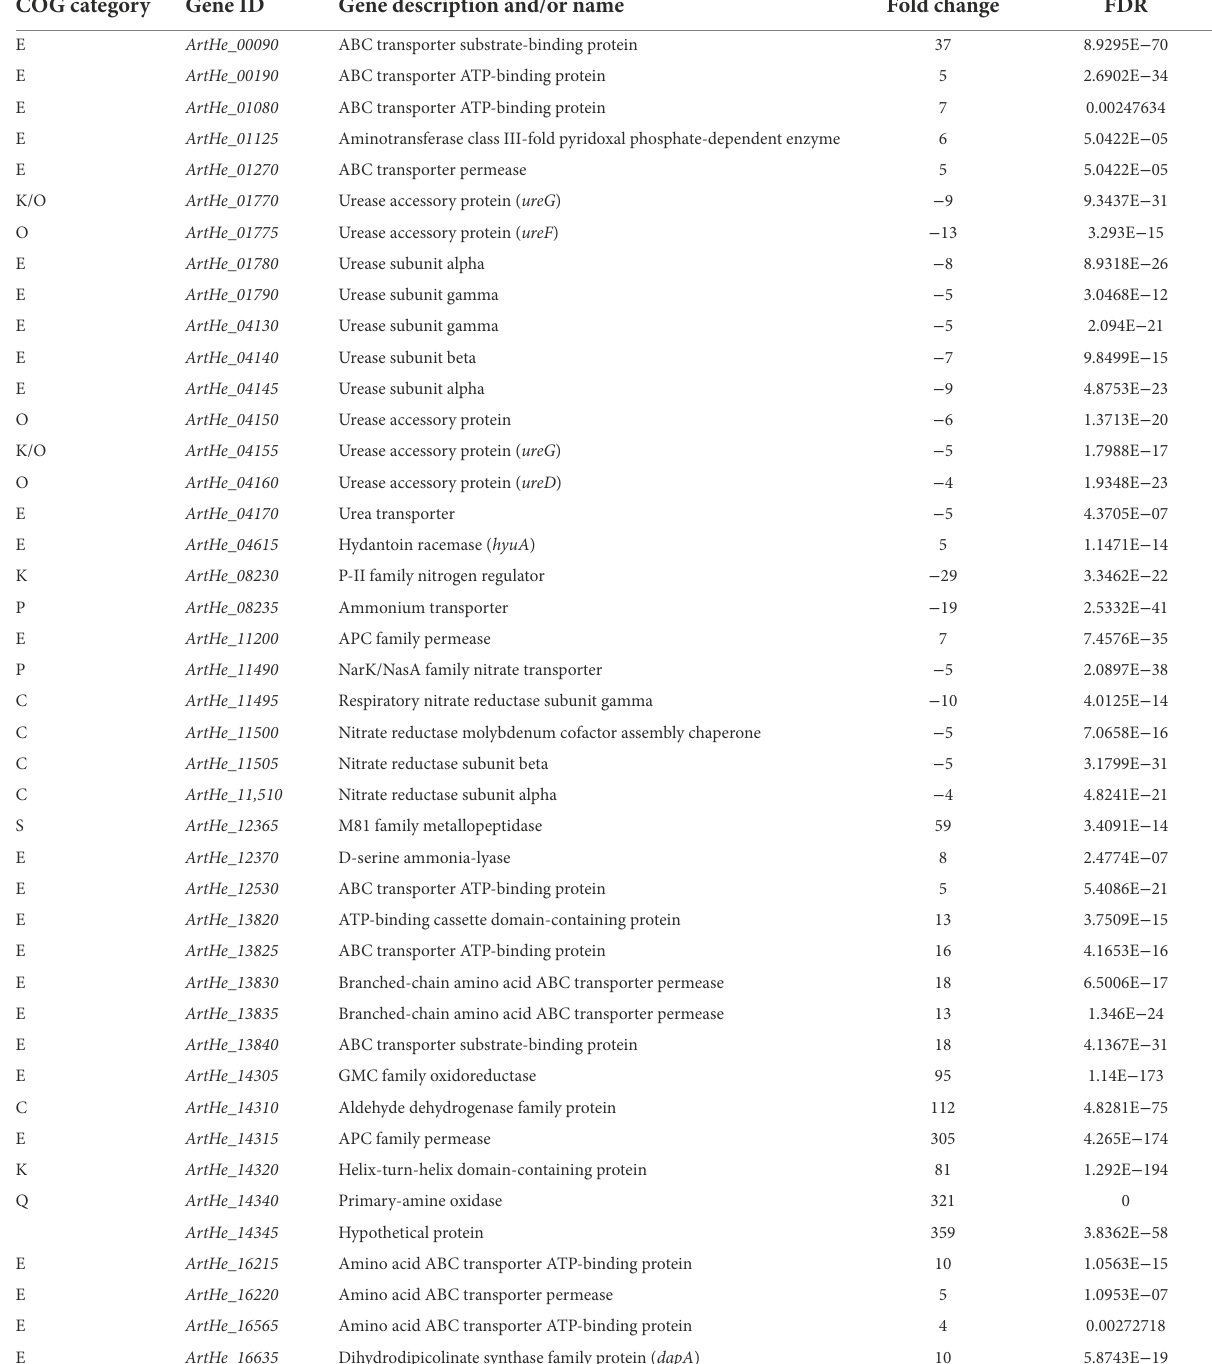
TABLE 2 DEGs involved in amino acid and nitrogen metabolism in PEG35 vs. PEG0. COG